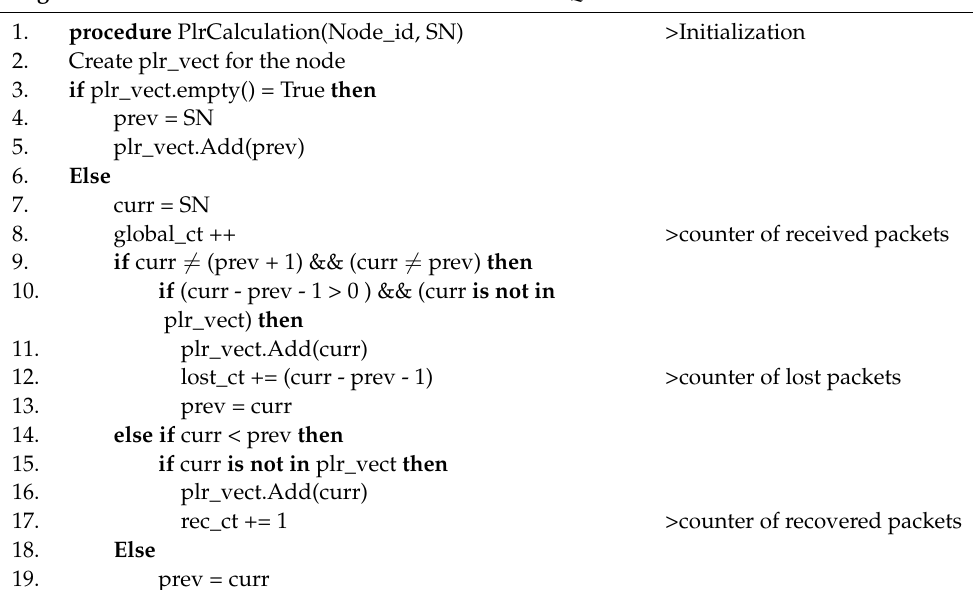
Algorithm 1. Packet loss rate calculation for MS-AL-ARQ.